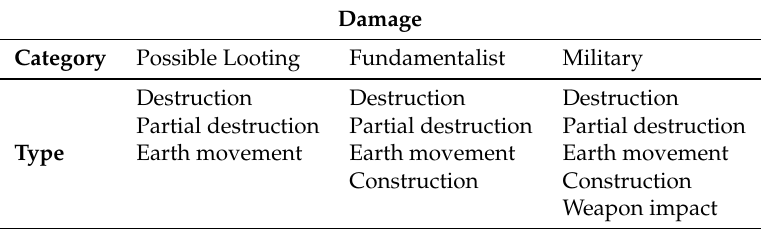
Table 3. Classification of damage observed by category and